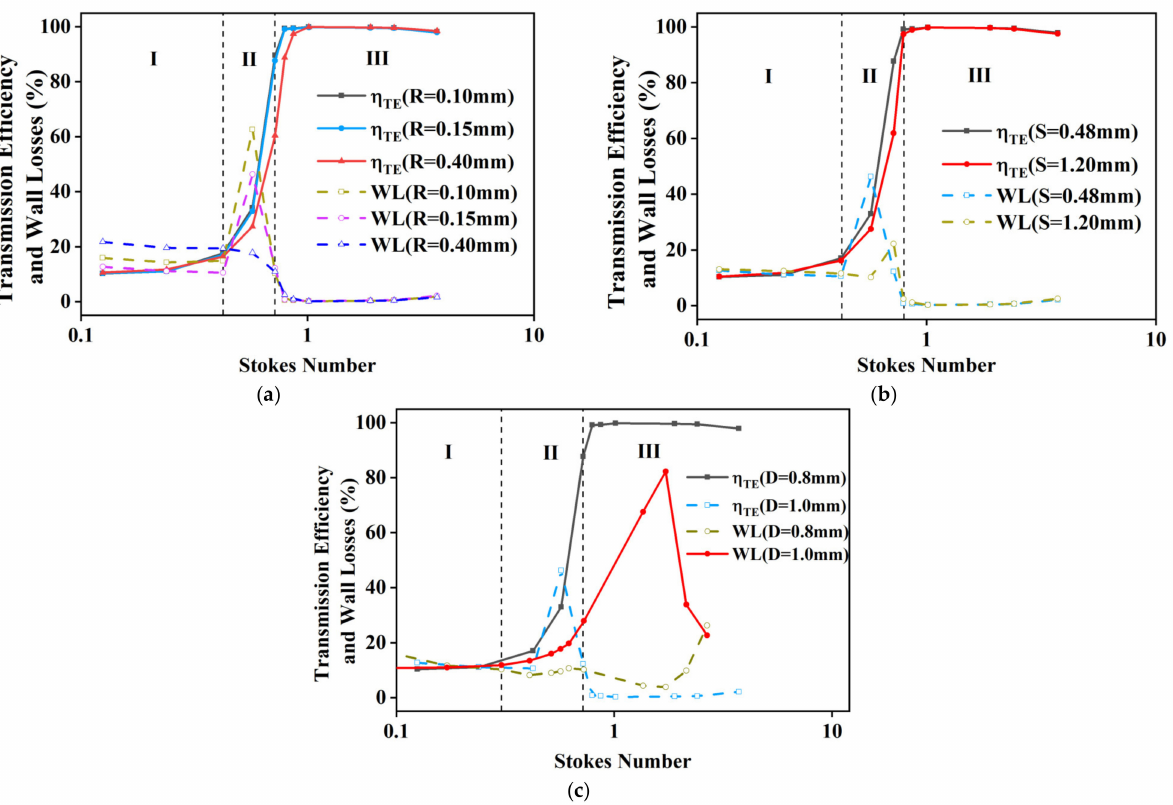
Figure 7. Influence of geometric factors on sampler performance. ( a ) Corner radius of the collecting nozzle. ( b ) Distance between the incident nozzle and the collection nozzle. ( c ) Throat diameter of the incident